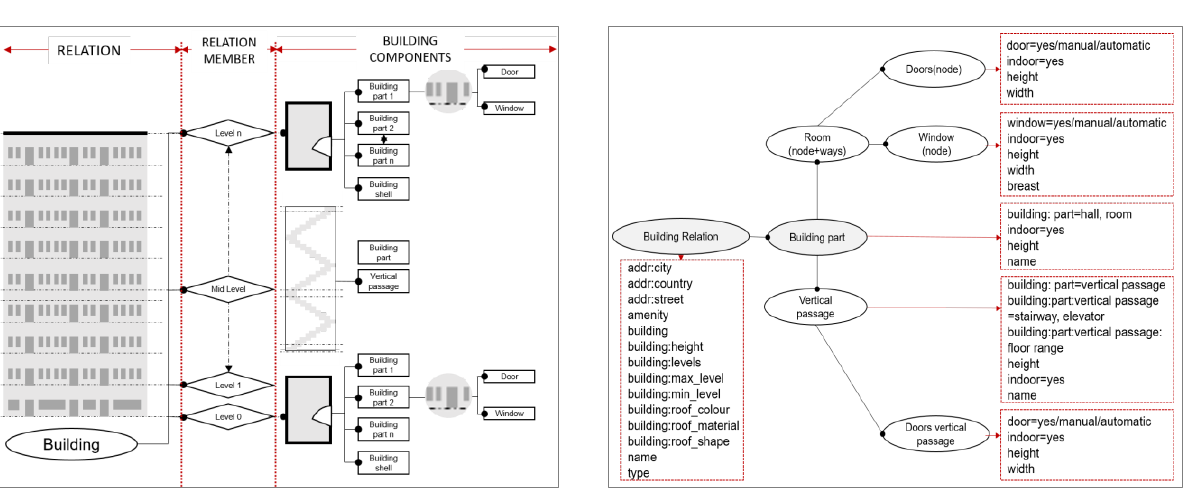
Figure 2. OSM exterior building model with indoor extensions Figure 3. IndoorOSM tagging